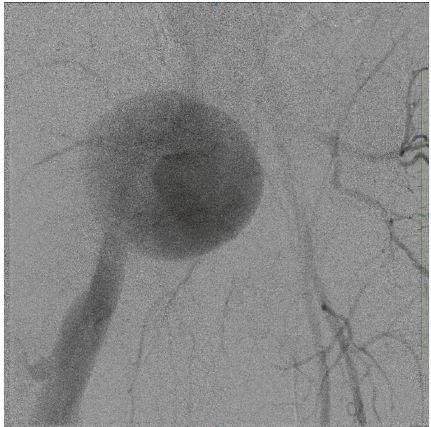
Figure 4: Right lower extremity angiogram showing possibility of a venous malformation, which was not seen on previous